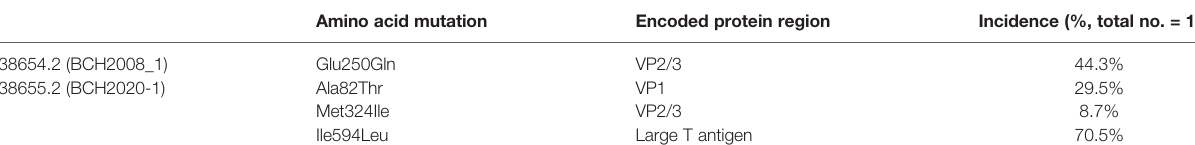
TABLE 2 | Non-synonymous changes in the amino acids of two WUPyV strains from fatal cases when aligned with the reference strain (GenBank accession no. NC_009539) and the incidences of each variation in all 149 complete WUPyV genomes submitted to GenBank.